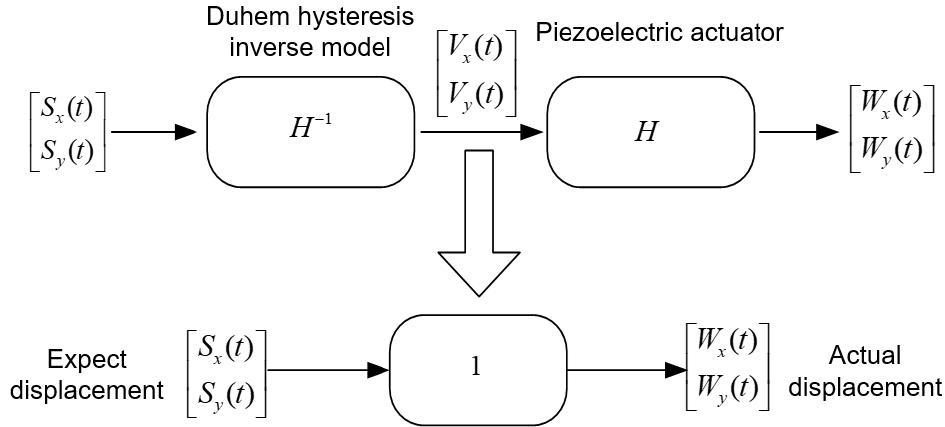
Figure 16. Feedforward control schematic.